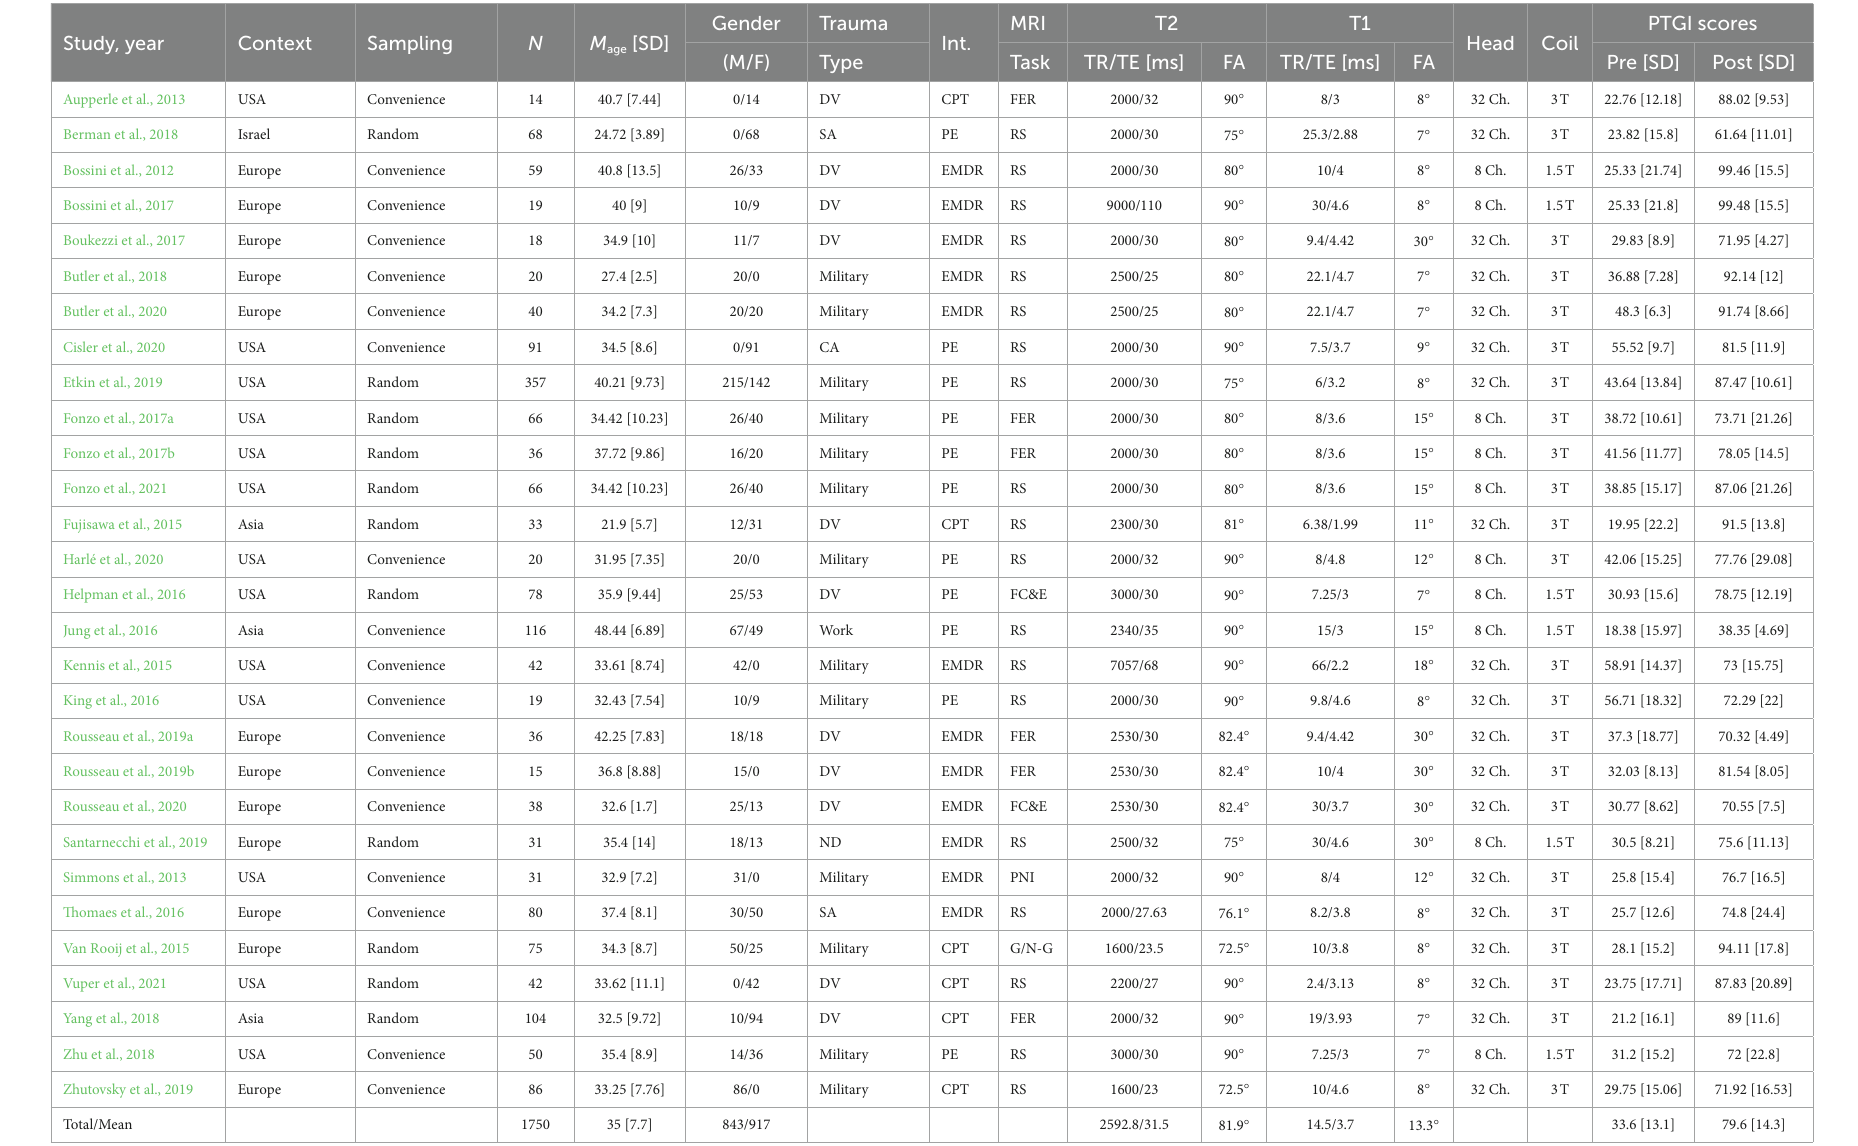
TABLE 2 Descriptive statistics from review